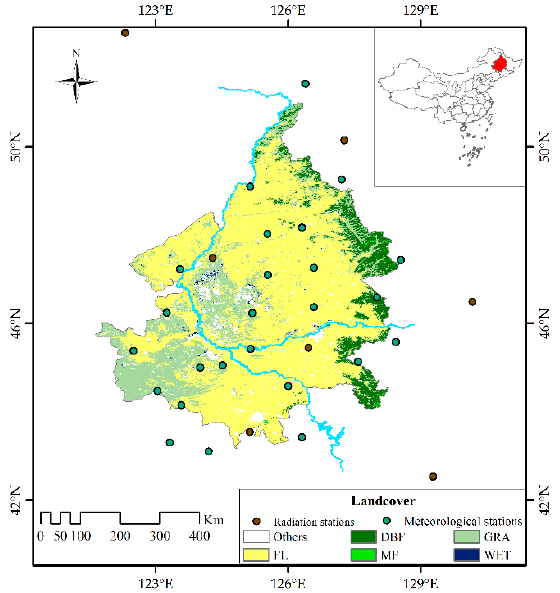
Figure 1. Study Area. FL: farmland; DBF: deciduous broad-leaved forest; MF: mixed forest; GRA: grassland and WET: wetland.